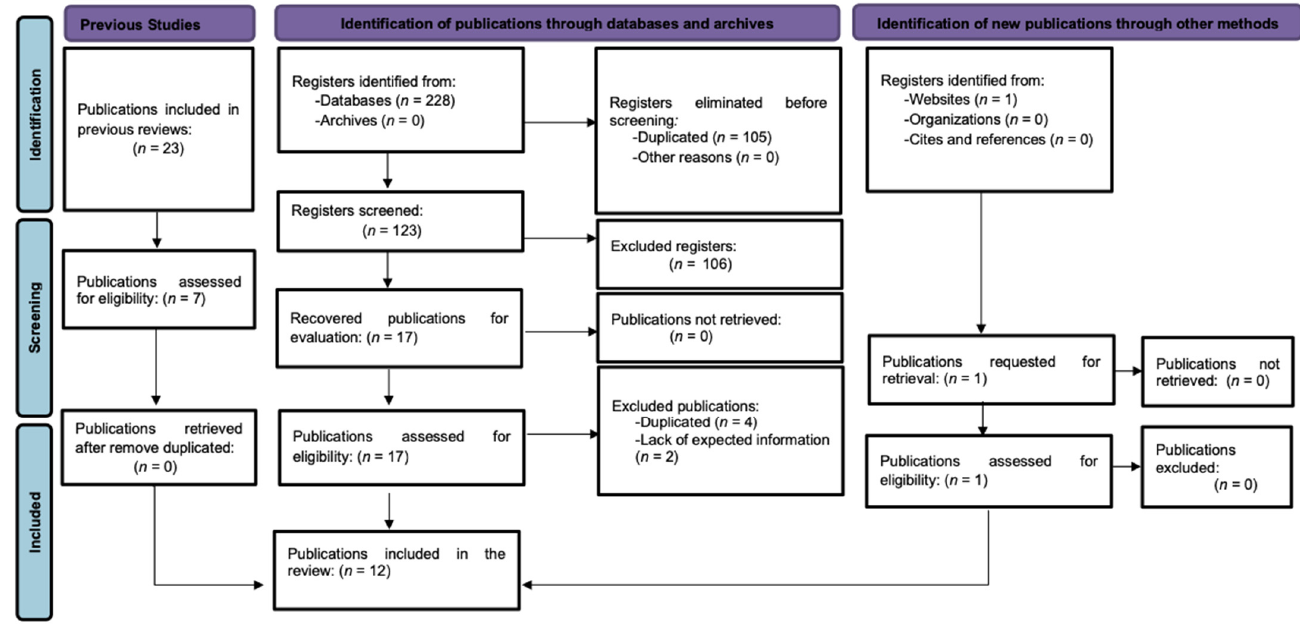
Figure 1. PRISMA flow diagram of the study selection.